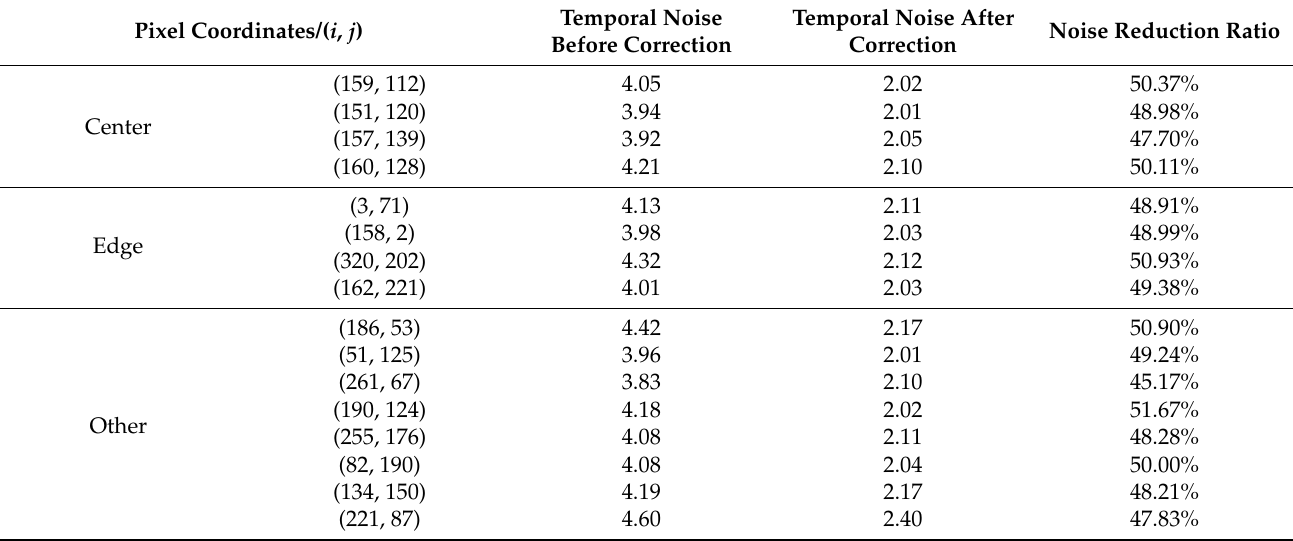
Table 2. Correction effect of imaged pixels.